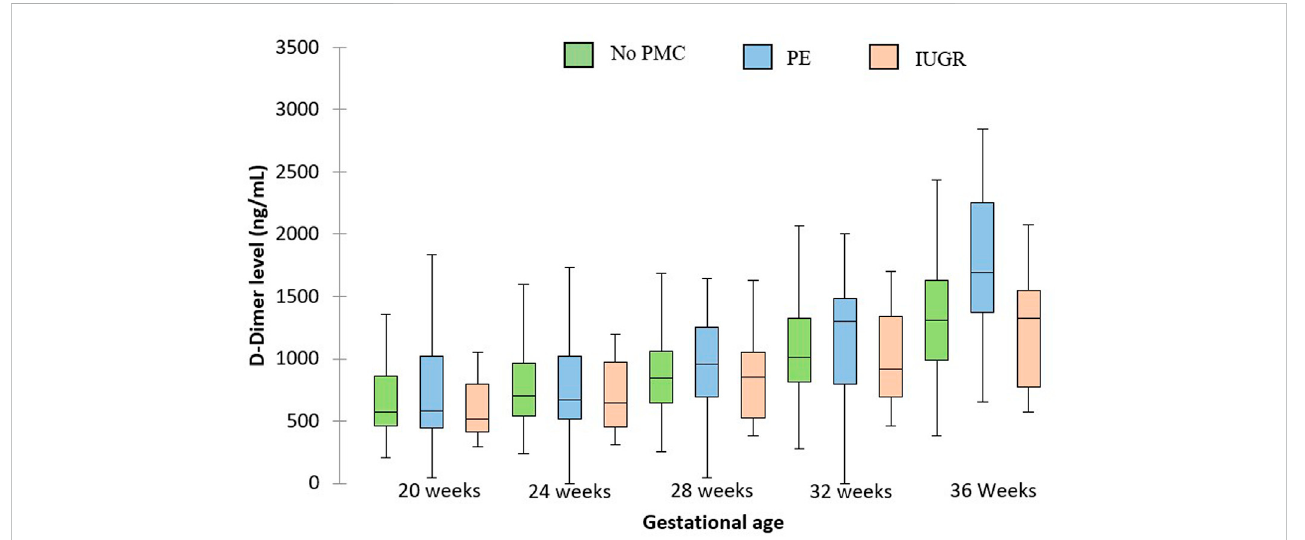
FIGURE 3 D-dimerlevelsateachgestationalageforpatientswithPE,IUGRanduncomplicatedpatients.Thecentralhorizontalbarsarethemedians.Thelowerand upper limits of the boxes are the fi rst and third quartiles. PMC: placenta-mediated complication.